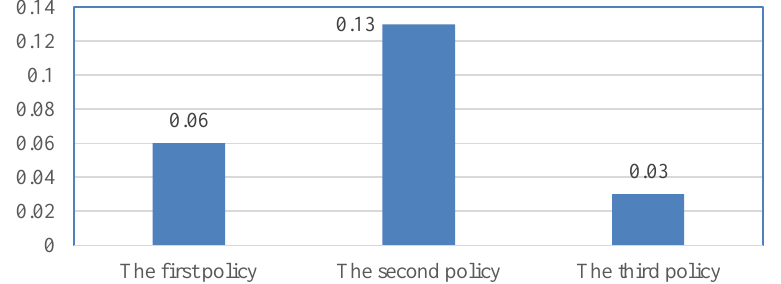
Figure 5. Waste separation at the source change percent in each policy